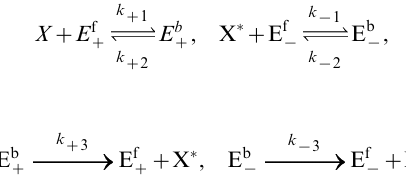
Figure 4. Genetic toggle switch. The values are given vs. t m . Markers are omitted for t m w 10 { 1 . (a) Probability deficiency ERR S p { Maximum and effective QTT ranks of the computed solution. (c) Relative norm Ap sec.)